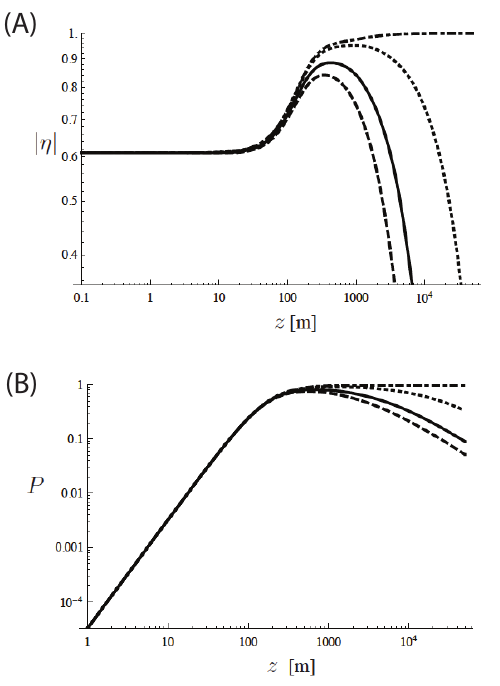
Figure 14. Changes in ( A ) the degree of coherence and ( B ) the degree of polarization of the electro- magnetic Gaussian–Schell model (EM GSM) in non-Kolmogorov turbulence. α = 3.01 (solid curve), α = 3.1 (dashed curve), α = 3.67 (dotted curve) and free space (dot-dashed curve). Reprinted with permission from Reference [90].